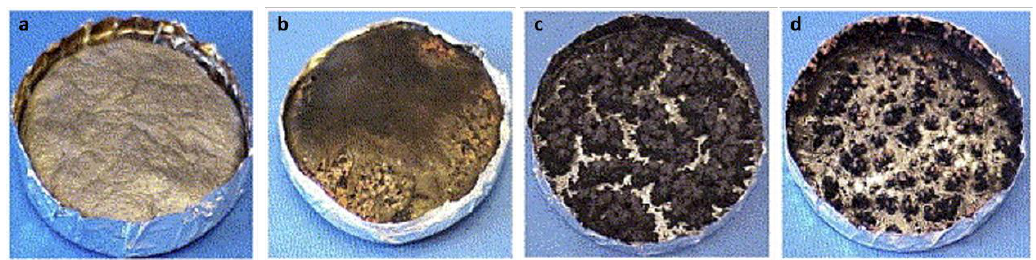
Figure 17. Effects of nanotube dispersion on residues of PMMA/SWNT nanocomposites (0.5%) (note: Samples were 8 and 4 mm thick for the gasification and burning test, respectively): ( a ) Nitrogen gasification residue and ( b ) burned residue of a sample with good dispersion; ( c ) nitrogen gasification residue and ( d ) burned residue of a sample with poor dispersion. Reprinted with permission from Ref. [161]. Copyright 2005, Elsevier.